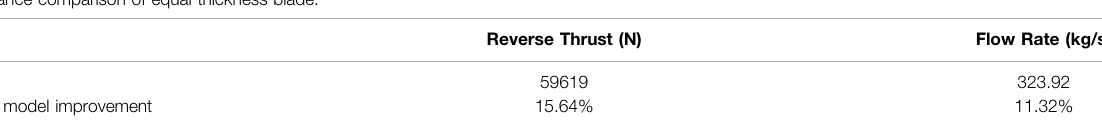
TABLE 3 | Performance comparison of equal thickness